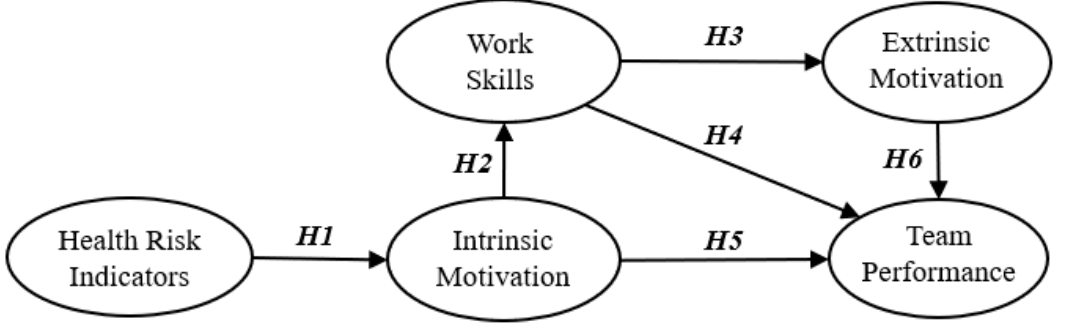
Figure 1. Hypothetical model for the perceptions of construction workers.